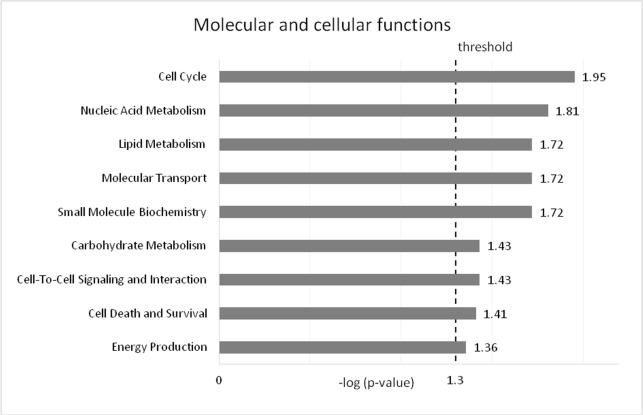
Molecular and cellular functions in DE genes in adipose tissue.The likelihood of the association between the genes in the dataset and a biological function is represented as–log (p-value), with larger bars being more significant than shorter bars. The vertical line indicates the cut-off for significance (p-value of 0.05).